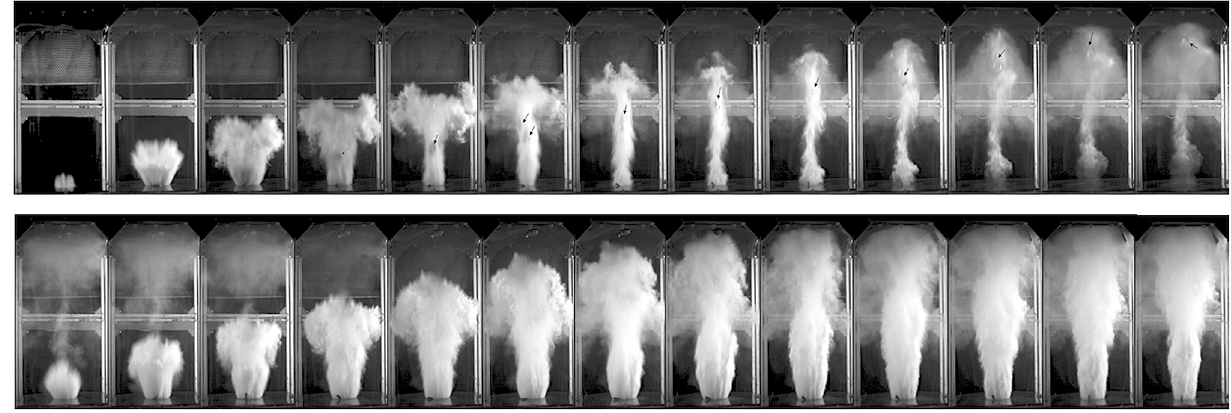
Fig. 9 High-speed images of the evolution of multiphase flow and the ruptured diaphragm fragments after diaphragm bursting. The time step between two images was 0.56 ms in both